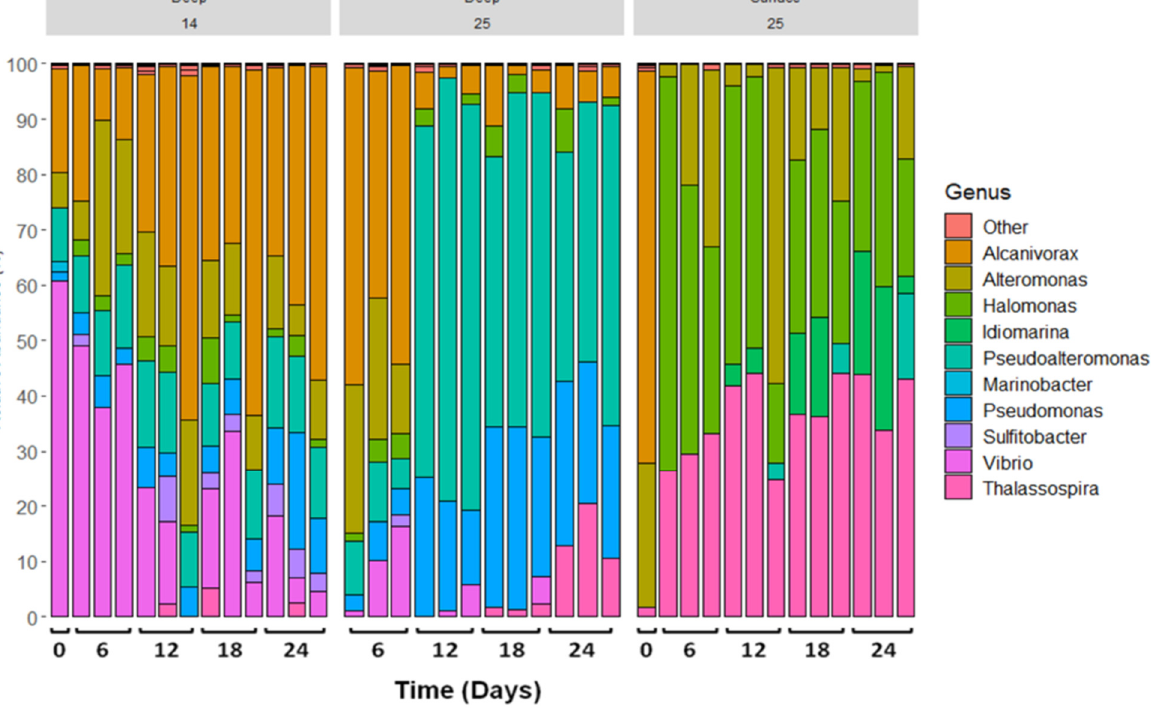
Figure 2. Relative abundance of bacterial taxa at the genus level plotted against time (days) and grouped by treatment (Deep14, Deep25 and Surface25). Taxa that are less than 1% in abundance are grouped as “Other”. Brackets on the x -axis correspond to the triplicate samples for the given timepoint. Day zero corresponds to the original D2 and S2 consortia and is common for the Deep14 and Deep25 treatments.